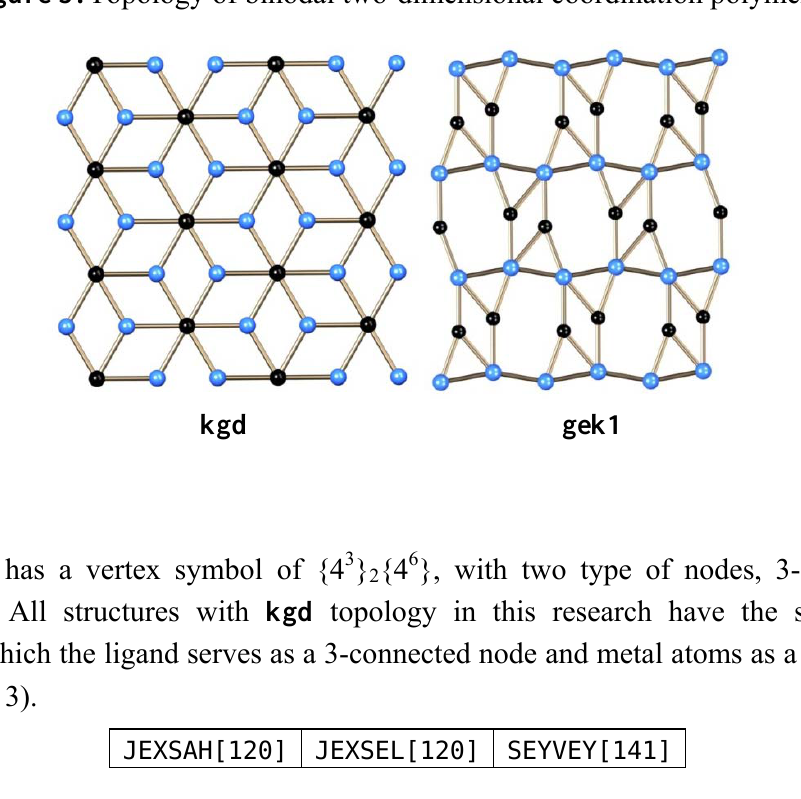
Figure 3. Topology of binodal two-dimensional coordination polymers.